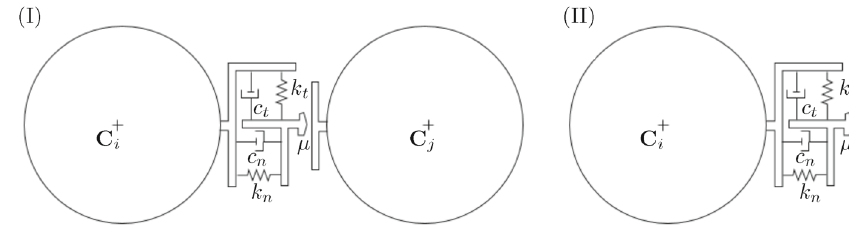
Fig. 2 Rheological model (I) for sphere-sphere contact. (II) for sphere-vertex/line/surface contact. Source [33]